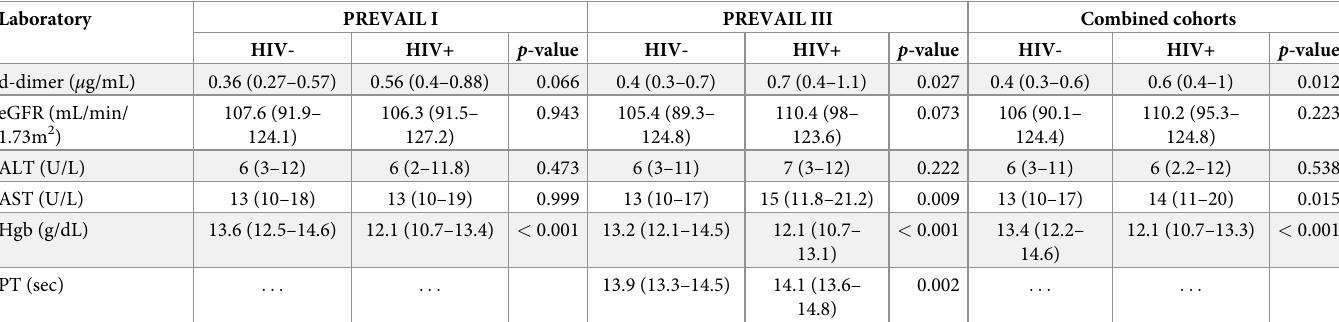
Table 4. Summary of baseline laboratories between HIV-positive and HIV-negative participants in PREVAIL I and PREVAIL III.